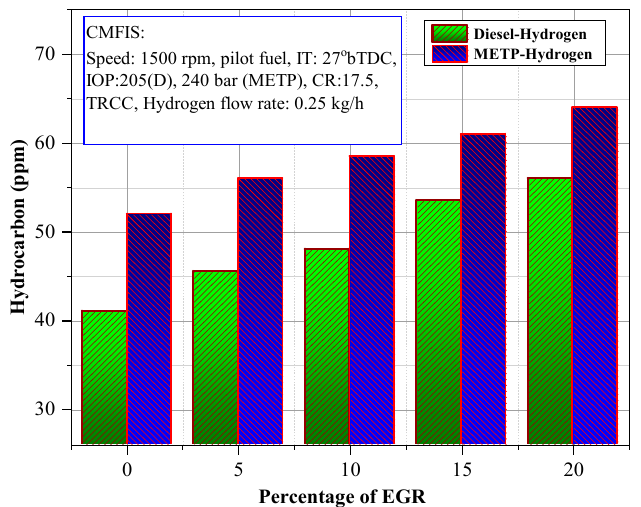
Figure 6. Influence of EGR on the smoke opacity with induction method.